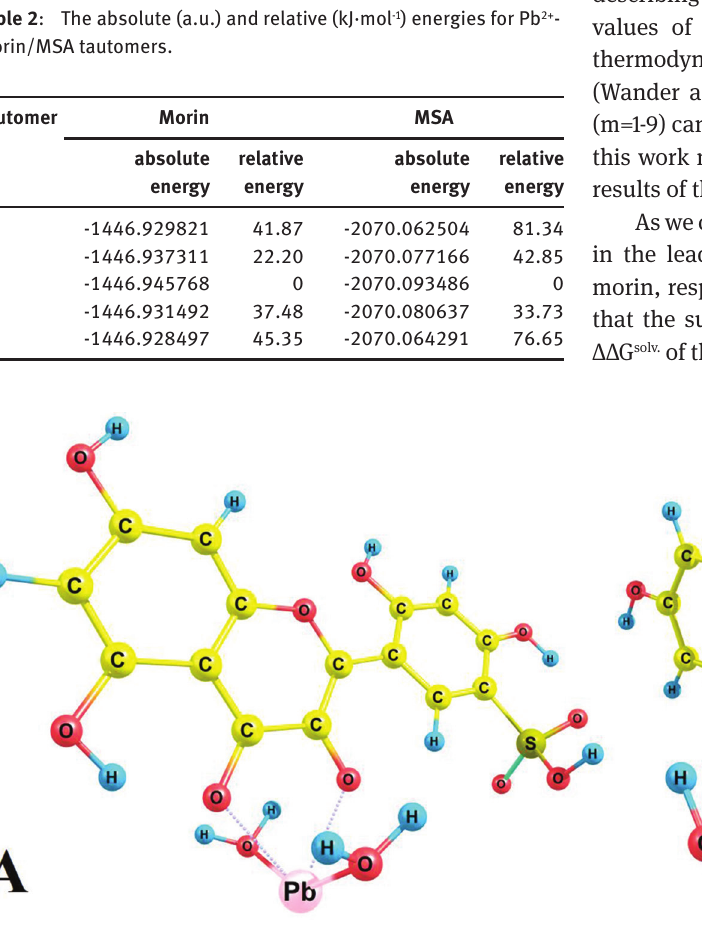
Figure 3: The optimization geometry for morin-Pb ( B ) and MSA-Pb ( A ).